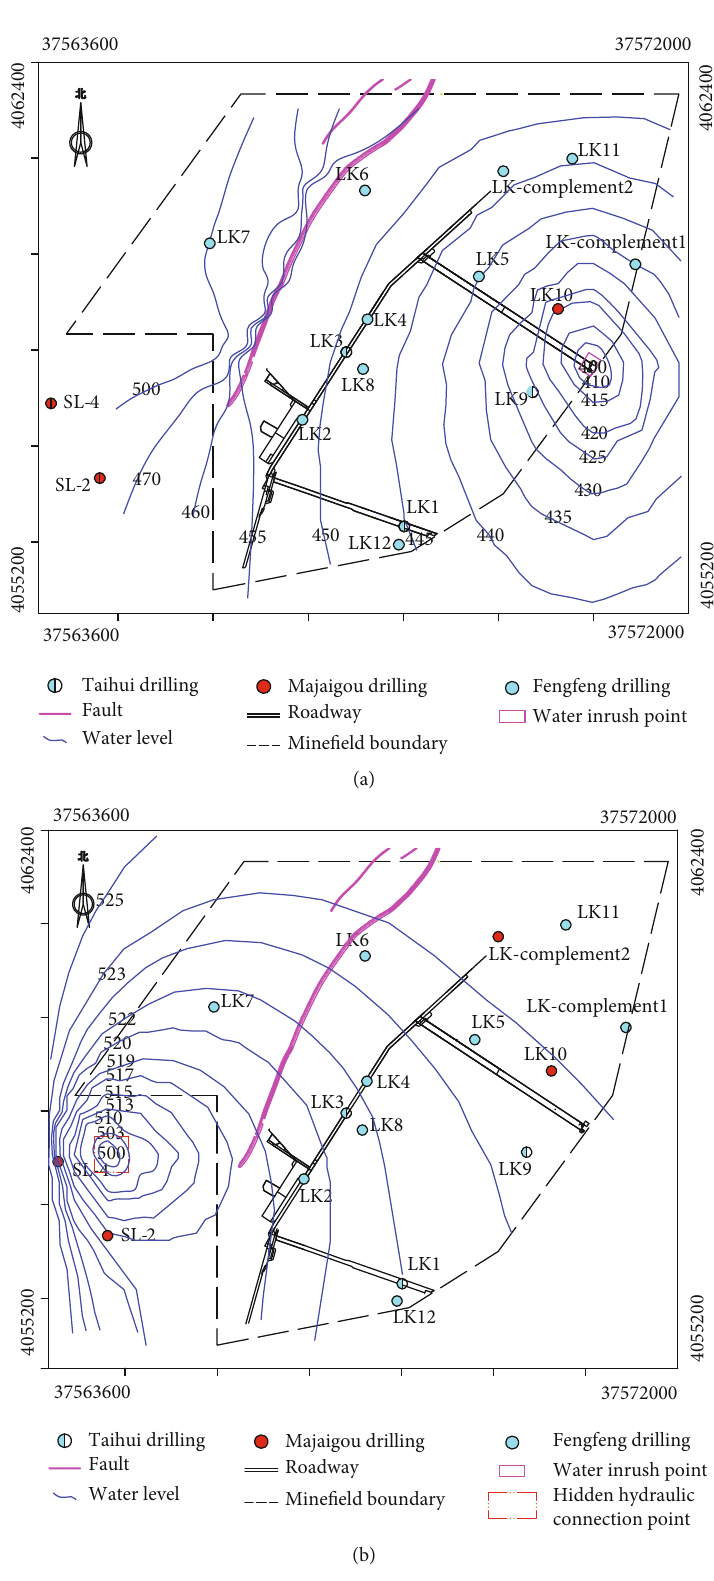
Figure 8: Water line of Ordovician aquifer: (a) equal water level in Fengfeng aquifer and (b) equal water level in Majiagou